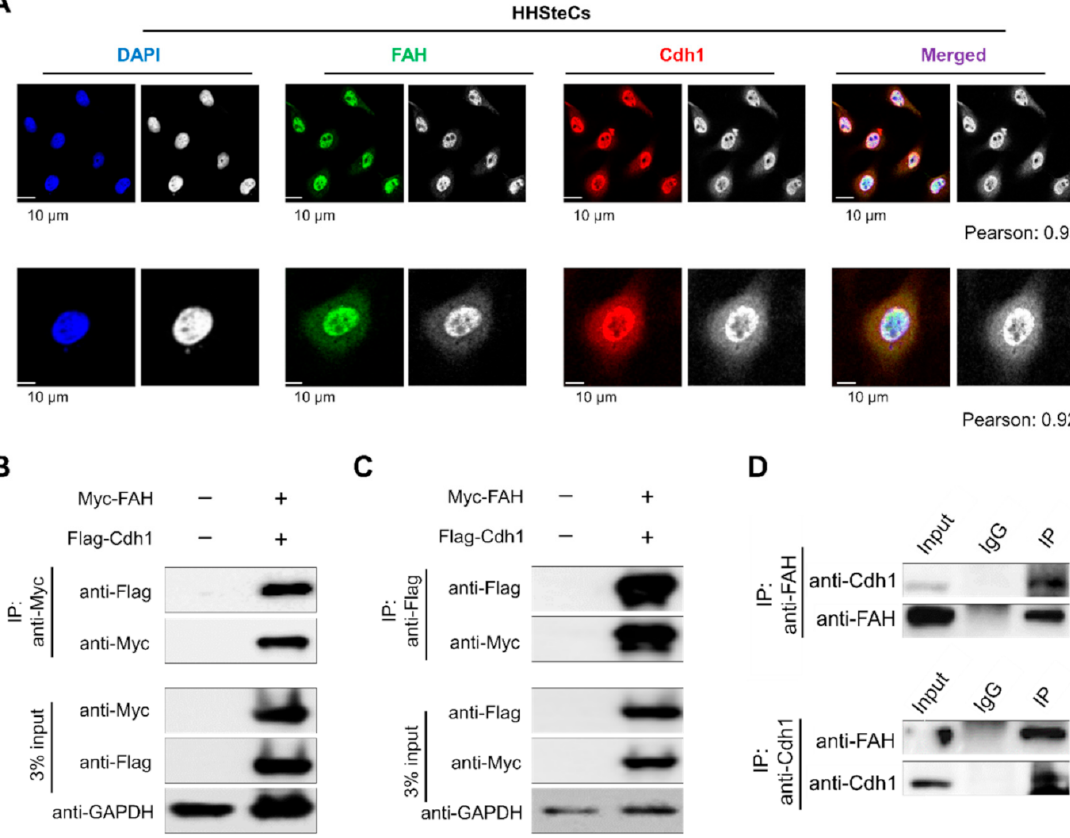
Figure 5. APC / C Cdh1 co-localizes and interacts with FAH. ( A ) Co-localization of FAH and Cdh1 was performed in HHSteCs by immunostaining with specific antibodies. DAPI was used for nuclear staining (scale bar: 10 µ m) and the quantification for colocalization coe ffi cients were done using Fiji / ImageJ software. To quantify the degree of co-localization in between the fluorochromes, the Pearson’s correlation coe ffi cient (r) was used. The classical Pearson coe ffi cient of the pixel-intensity correlation of colocalization obtained from the coloc2 analysis were mentioned. ( B ) Myc-tagged FAH and Flag-tagged Cdh1 were co-transfected into HEK293 cells. Samples were immunoprecipitated using anti-Myc and immunoblotted using anti-Flag antibodies. GAPDH was used as the loading control. ( C ) Myc-tagged FAH and Flag-tagged Cdh1 were co-transfected into HEK293 cells. Samples were immunoprecipitated using anti-Flag and immunoblotted using anti-Myc antibodies. GAPDH was used as the loading control. ( D ) Endogenous binding between FAH and Cdh1 proteins was performed in HHSteCs. Cell lysates from HHSteCs were immunoprecipitated with specific FAH or Cdh1 antibodies and immunoblotted with FAH or Cdh1